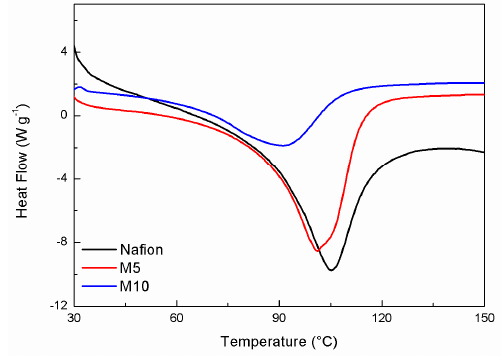
Figure 1. DSC response of the hydrated membrane samples. Table 1. ∆ H and T onset associated to the thermal transition observed by DSC.